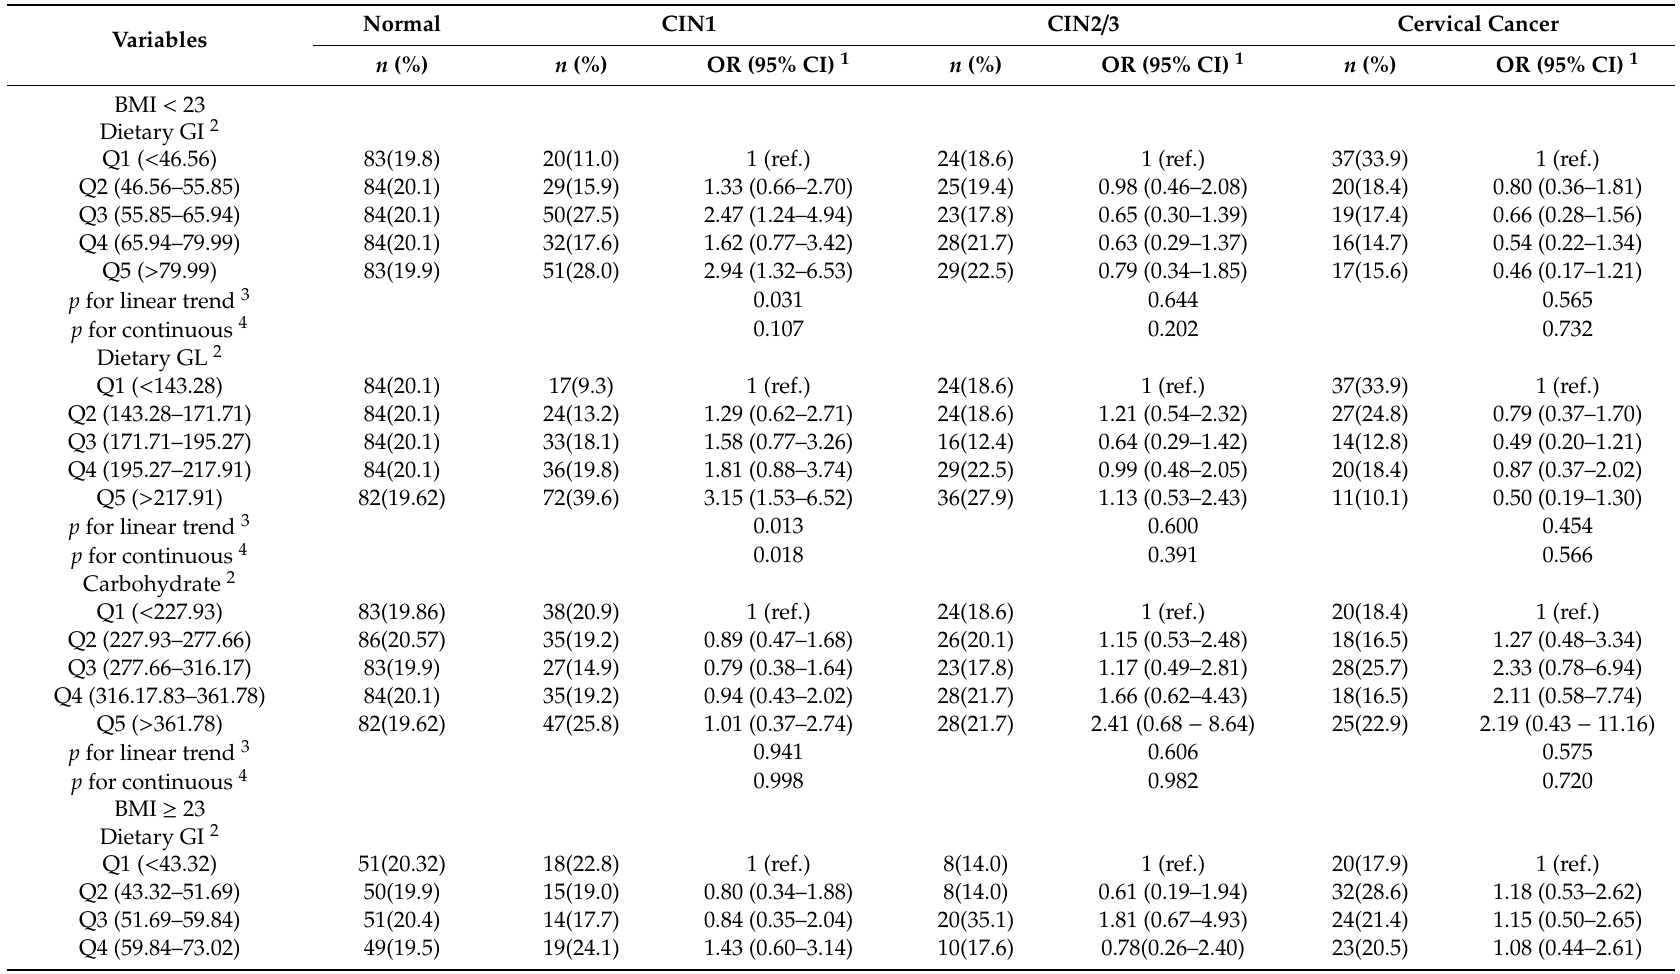
Table 3. Multivariate ORs of dietary glycemic index (GI) and glycemic load (GL) for the risk of CIN and cervical cancer stratified by